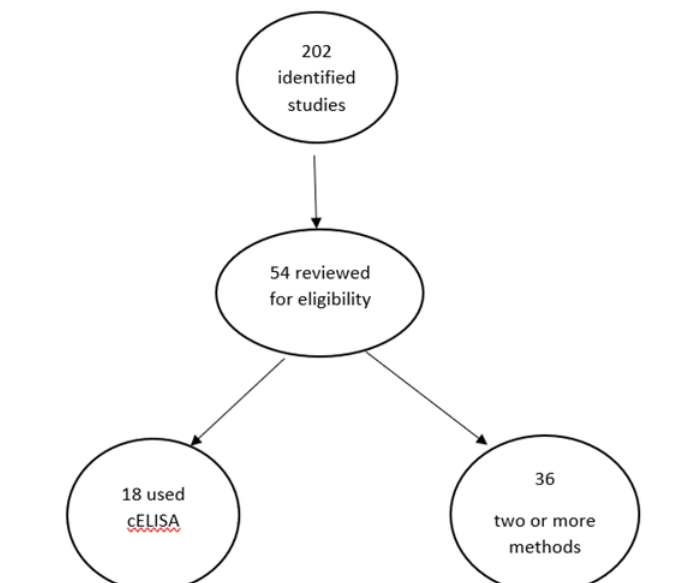
Figure 2. Selection process of studies using serological diagnostic